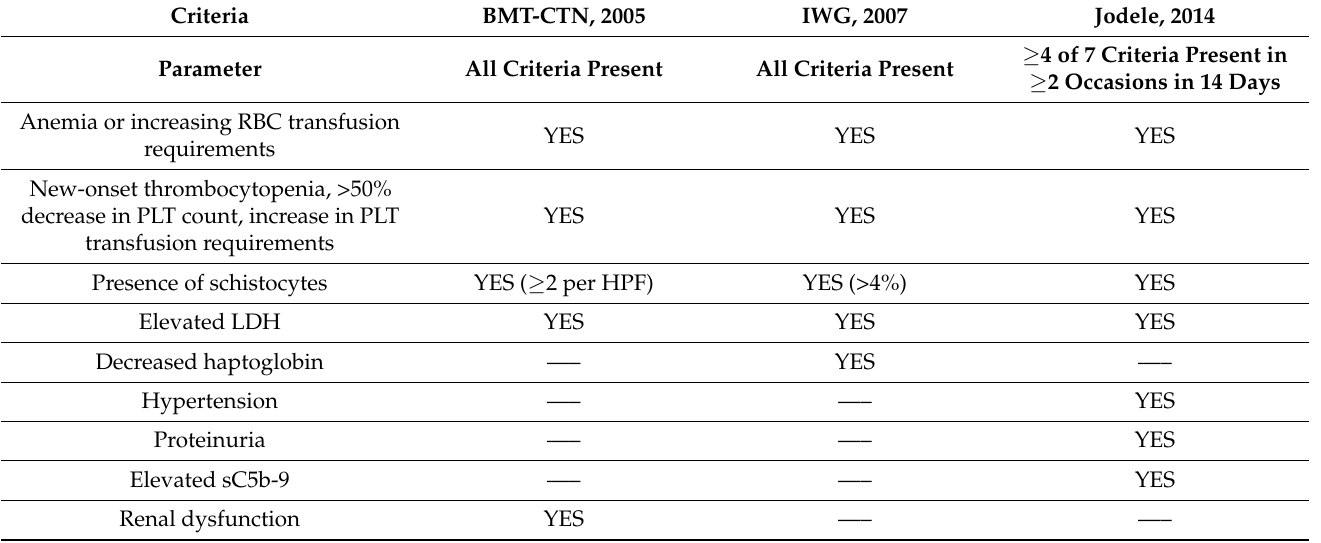
Table 1. Proposed diagnostic criteria for thrombotic